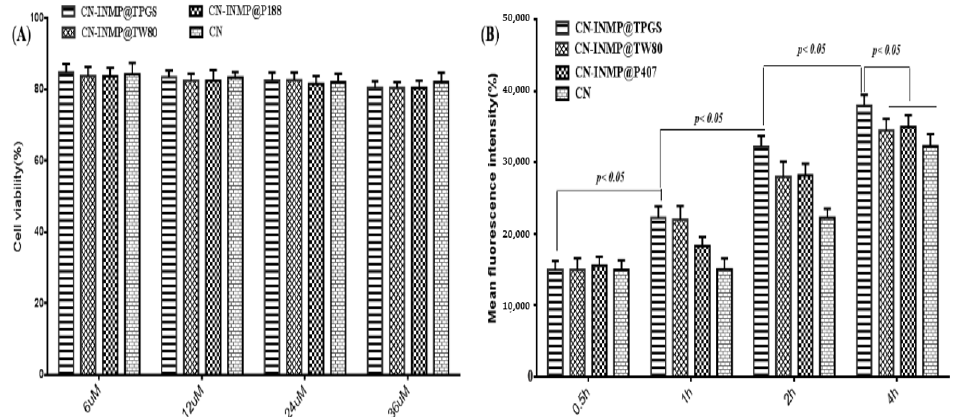
Figure 8. The cell viability( A ) and cell uptake( B ) of CN-INMPs.